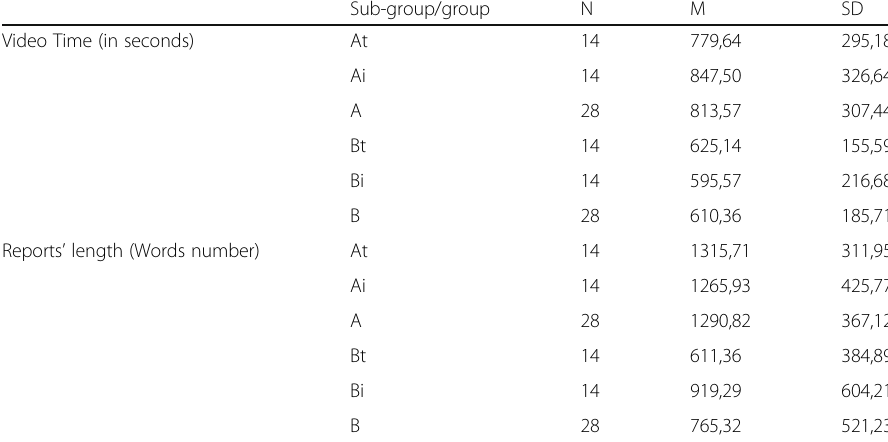
Table 3 Report and video characteristics split into Group (A and B) and subgroups (At, Bt, Ai, Bi) Sub-group/group N M SD Video Time (in seconds) At 14